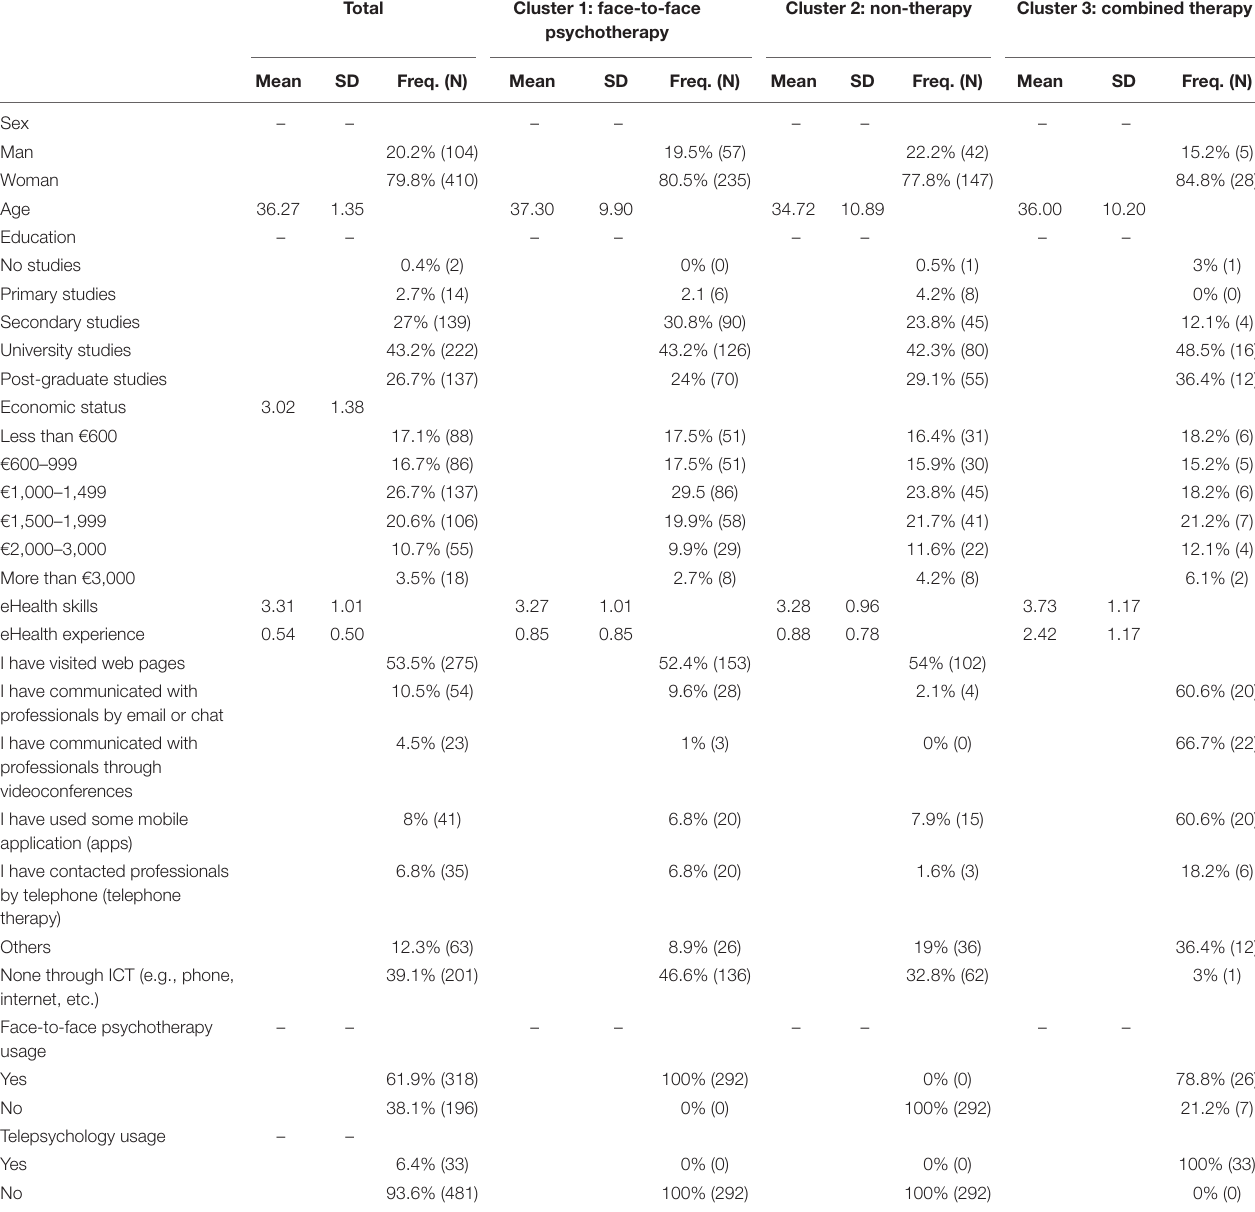
TABLE 1 | Characteristics of participants in the study.